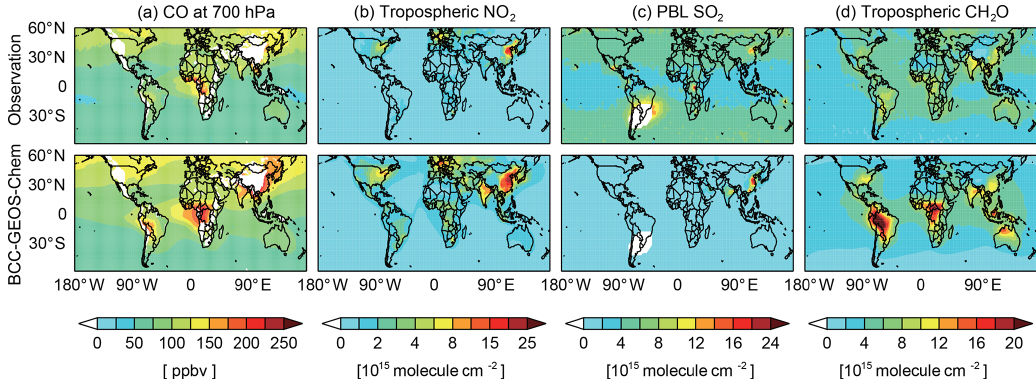
Figure 10. Spatial distributions of satellite observed (top panels) and model simulated (bottom panels) annual mean (a) CO mixing ratio at 700hPa, (b) tropospheric NO 2 column, (c) SO 2 column in the planetary boundary layer, and (d) tropospheric CH 2 O column. Values are 3-year averages over 2012–2014.